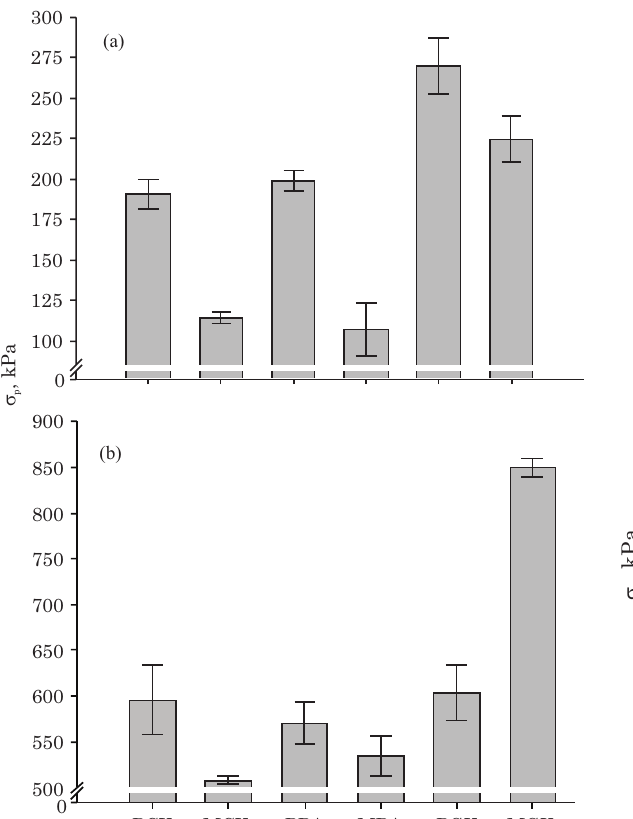
Figura 5. Médias da pressão de preconsolidação ( σσσσσ p ) de amostras de solo equilibradas em alta umidade (a) e baixa umidade (b), para os usos, mata e pastagem em Cambissolo Háplico, Argissolo Amarelo e Gleissolo Háplico. A barra de erros representa o erro-padrão da média.